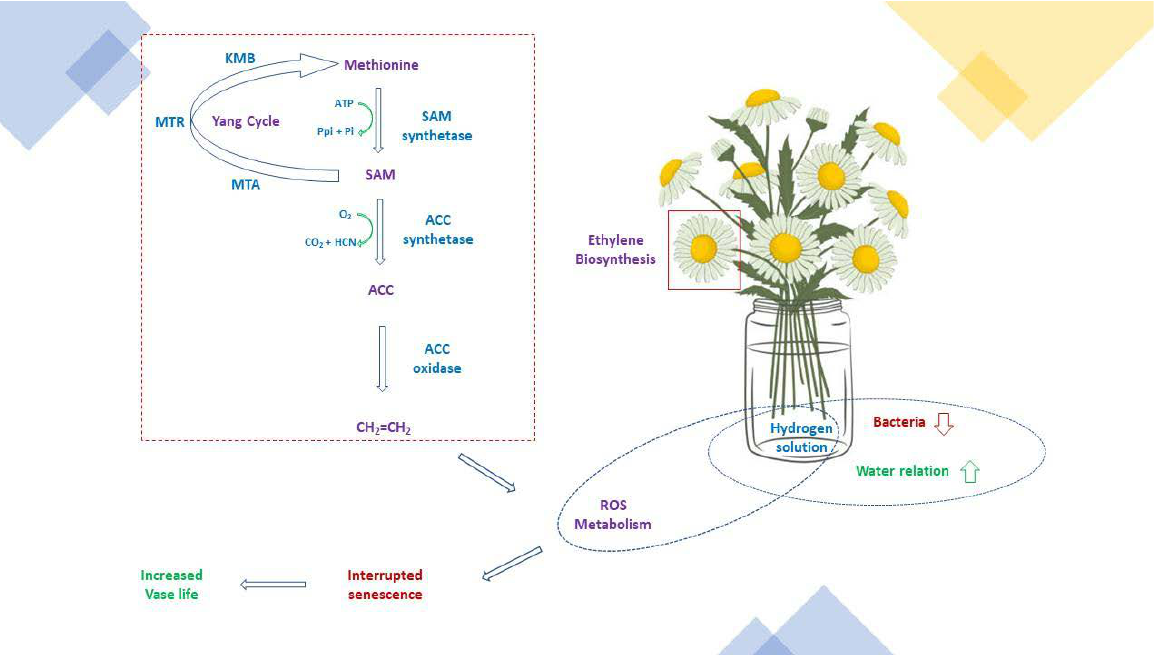
Figure 1. Possible roles of the effective hydrogen solution in floral preservative